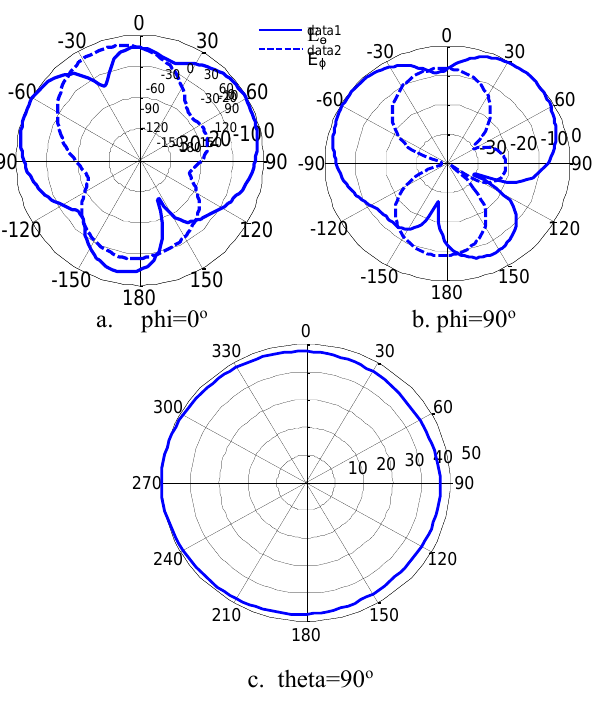
Figure 8: Radiation pattern of two SDRA antennas at frequency 6.62